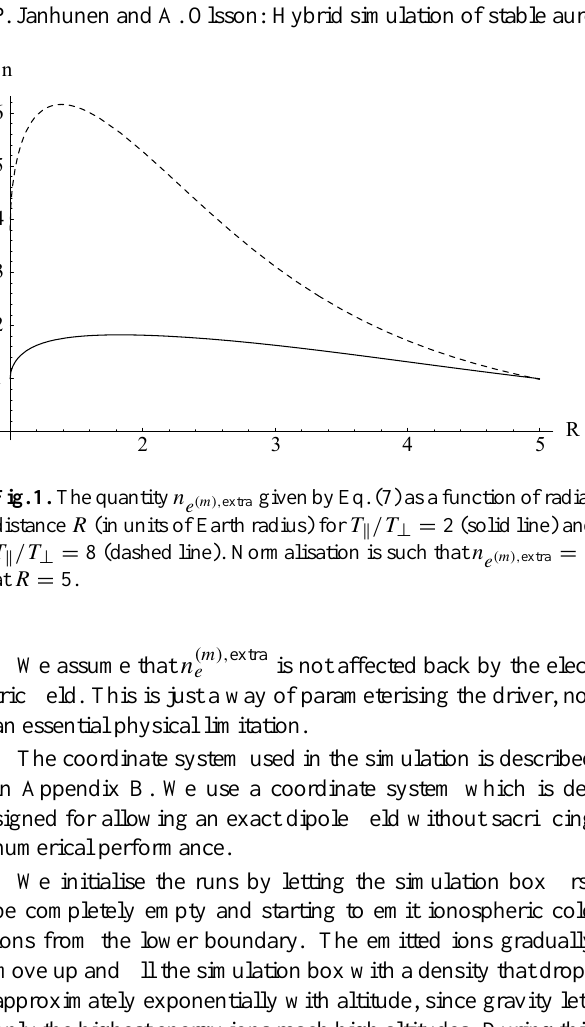
Fig. 2. Density of cold ionospheric ions at t = 400s, averaged over the previous